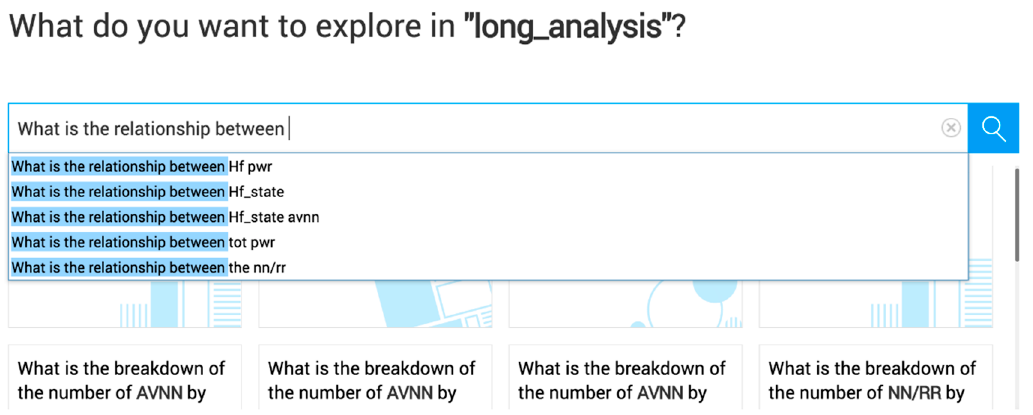
Figure 8. Text questions typed by user to inspect data relations or distributions.